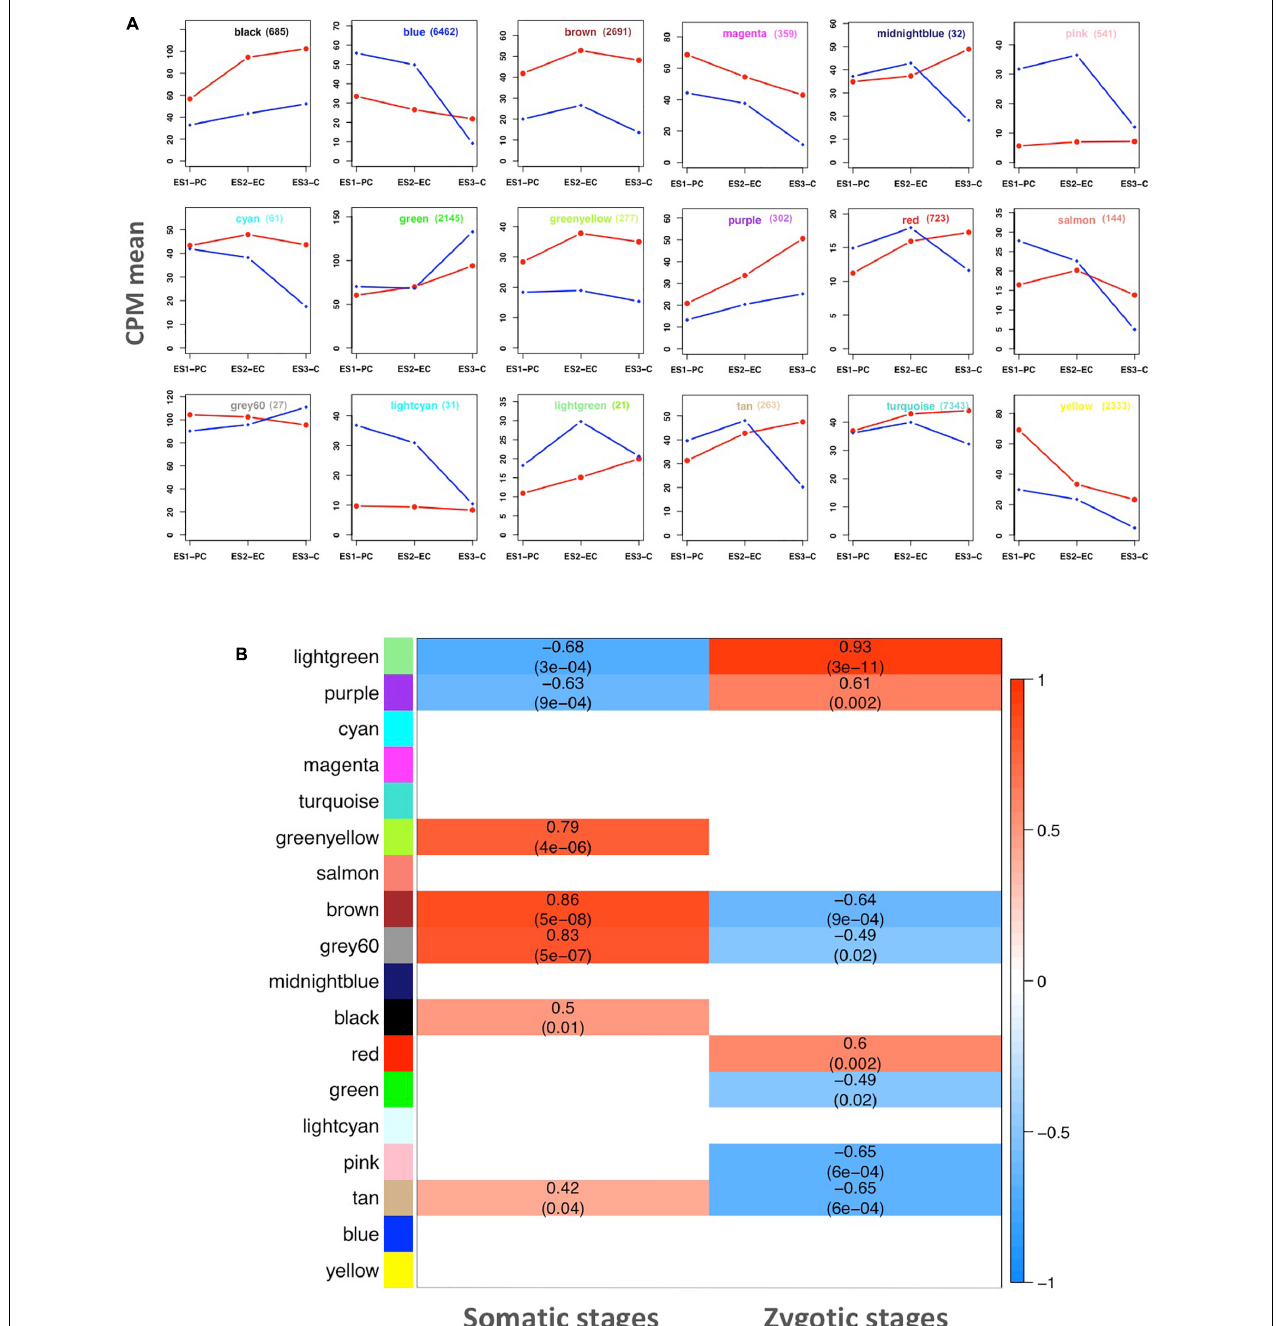
FIGURE 3 | Gene co-expression network analysis. (A) Mean expression profile of genes in each correlation module representing correlative developing stages (CPM, counts per million mapped reads). The number of genes included in each module is shown by its name. Zygotic developmental stages: PC, EC, and C represented in blue. Somatic developmental stages: ES1, ES2, and ES3 are represented in red. Data are means of three values from the RNA seq reactions. (B) Heat map showing the relationships between the modules and embryo developmental stages. The correlation, positive (light to dark red) or negative (light to dark blue) with either somatic or zygotic embryos data globally represented is